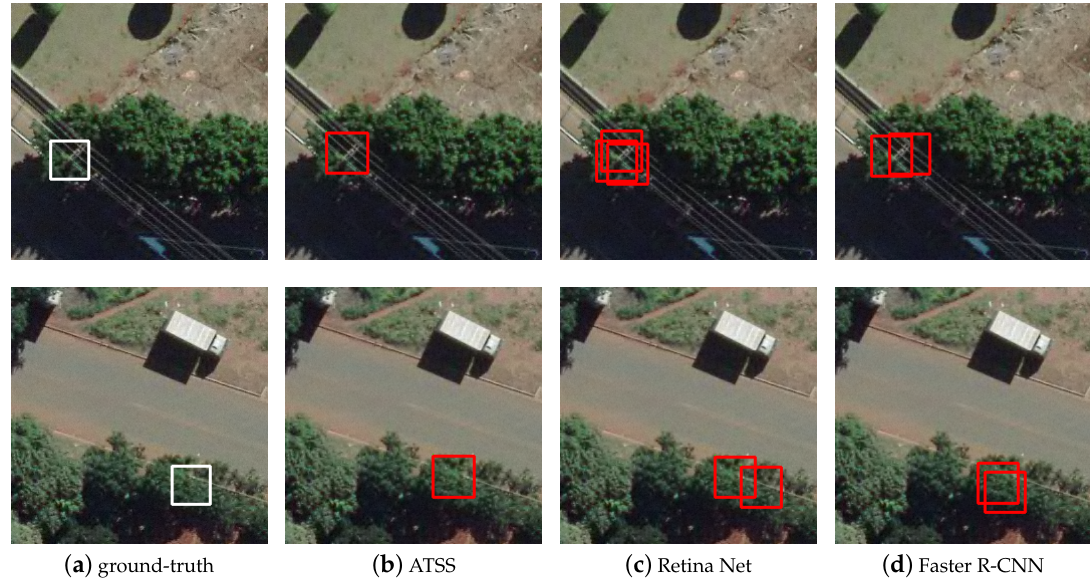
Figure 5. Results obtained by the methods when locating utility poles occluded by trees tops: ( a ) the ground-truth; ( b ) ATSS; ( c ) RetinaNet; and ( d ) Faster